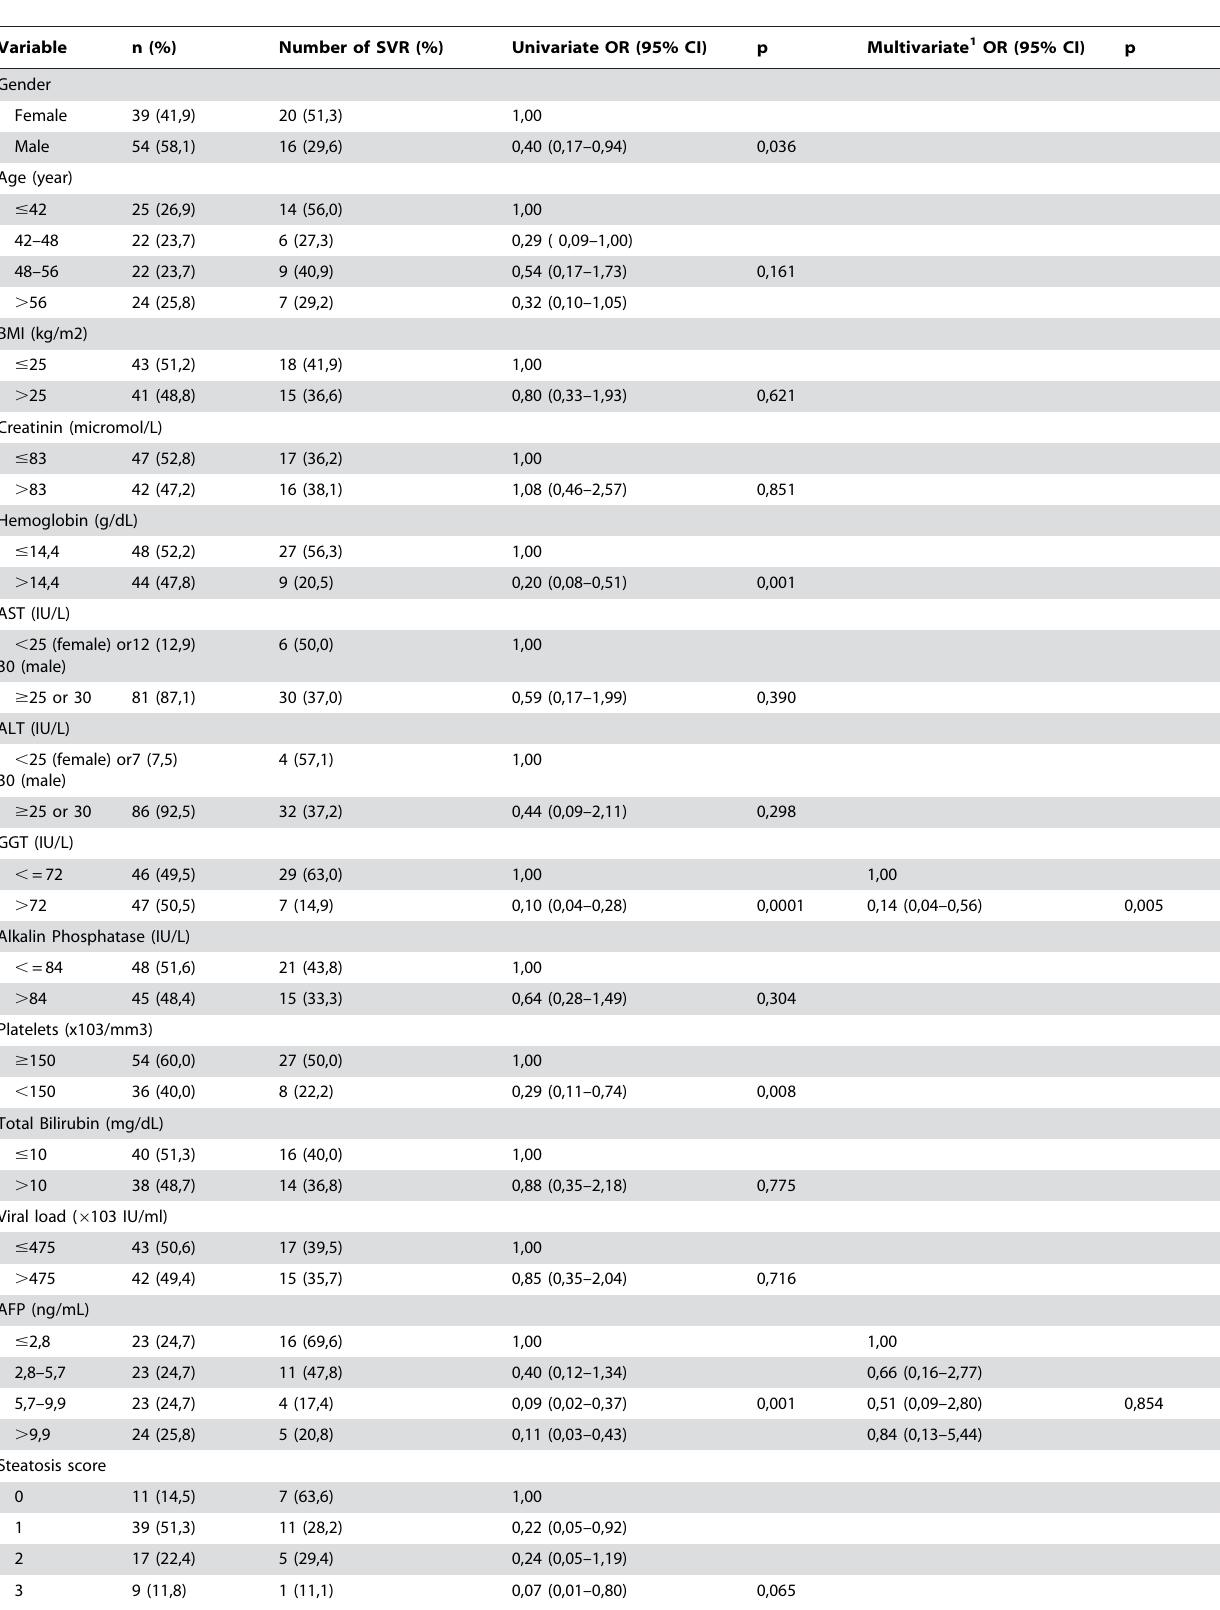
Table 1. Relationship between socio-demographical, biological and histological variables and SVR among 93 chronic hepatitis C patients treated with combined